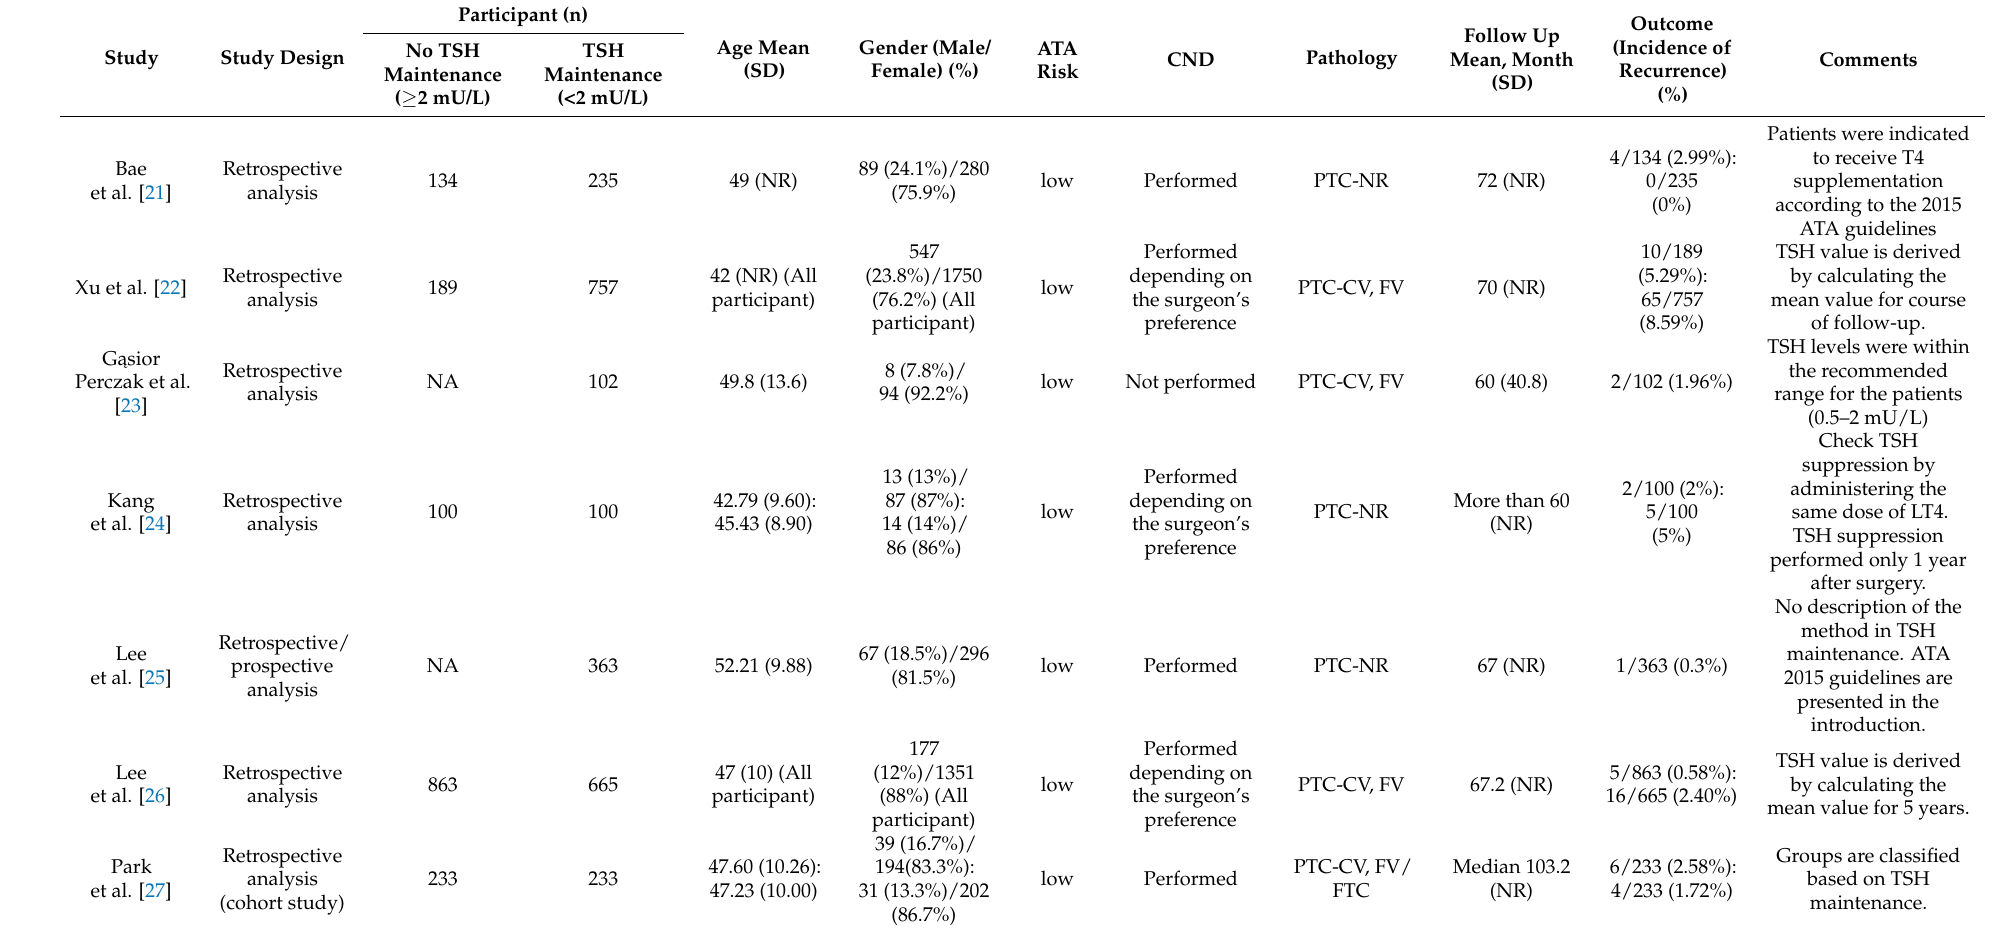
Table 1. Studies included in the systematic review and